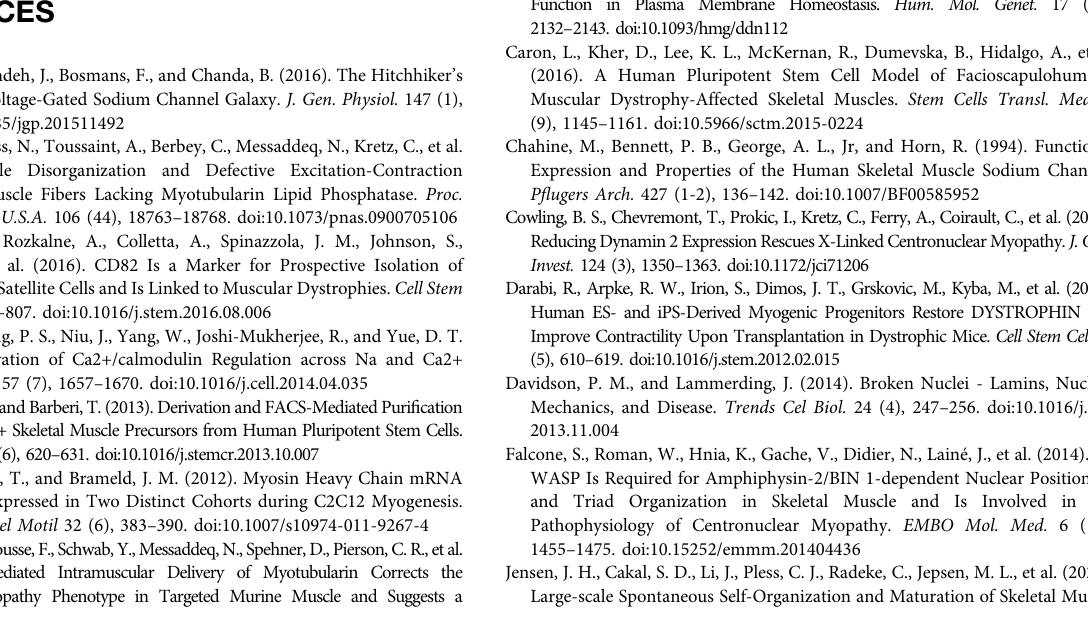
Supplementary Figure S2 | Puri fi cation of iMuSCs from the mesoderm cell population by fl ow cytometry using CD57 and CD82 antibodies. (A) Schematic of the fl ow cytometry data. CD57-negative and CD82-positive cells are located in the P5 fraction as purple dots. (B) The mRNA expressions of Pax7, MyoD, and Myf5 were quanti fi ed by real-time qPCR in every fraction (CD57- CD82+, CD57+ CD82+, CD57- CD82-, CD57+ CD82-) puri fi ed by fl ow cytometry. The expression level of these three genes in unsorted samples was set as the control. The vertical axis of the graph shows the relative expression level normalized by b-actin, the housekeeping gene. The expression level in each fraction was standardized by the expression level of the unsorted (unsort) sample. (The relative expression of Pax7 in the unsorted sample is 1.) Pax7, MyoD, and Myf5 were abundantly expressed in the CD57 – CD82+ fraction compared with the unsorted sample. (C) The protein expression of Pax7 in every fraction by immunocytochemistry. (Left) Pax7-positive cells were abundant in the CD57 – CD82+ fraction compared with those in the other fractions (CD57+ CD82+, CD57- CD82-, CD57+ CD82-). * < 0.05 ** < 0.01, unpaired two-tailed Student ’ s t-test. Supplementary Figure S3 | Representative images of myotubes on days 5 (A) , 7 (B) , 14 (C), and 42 (D) of the culture. Right panels are magni fi ed images. Scale bars, 100 µm (left) and 100 µm (right). Supplementary Figure S4 | (A) Schematic of the 3D Matrigel covering. Blue (myotube), beige (differentiation medium; DM), and red (Matrigel mixture). (B) Schematic of the two conditions (m-condition and c-condition) for the differentiation. (C,D) Representative images of myotubes (anti-MHC, green) in c-condition and m-condition. There was a signi fi cant increase in the size of PAX7 -Venus and CD57-CD82+ iMuSC-derived myotubes at day 42 of the culture ( n =45 and n =46 myotubes from control and Matrigel samples, respectively). Scale bar, 100 µm. Supplementary Figure S5 | The mRNA expression of the myosin heavy chain family ( MYH2, MYH3, MYH4, MYH7, and MYH8 ) , SR-related genes ( Casq1 and Atp2a1 ) , and t-tubule-related genes ( DHPR α , DHPR β , and DHPR γ ) was quanti fi ed by real-time PCR. The expression level of each gene in PAX7 -Venus iMuSC-derived myotubes on days 14 and 42 between with and without Agrin was shown. Matrigel embedding was performed in both with and without Agrin conditions. The vertical axis of the graph shows the relative expression level normalized by 18S rRNA, the housekeeping gene. The expression level is standardized by the expression level (=1) on day 5. * p < 0.05, ** p < 0.01 (unpaired two-tailed Student ’ s t-test). Error bars indicate thestandarderrorofmean(SEM).Ineachgroup(day14;Agrin+ Agrin-,day 42; Agrin+ Agrin-), three independent samples were used for the analysis. SupplementaryVideoS1|